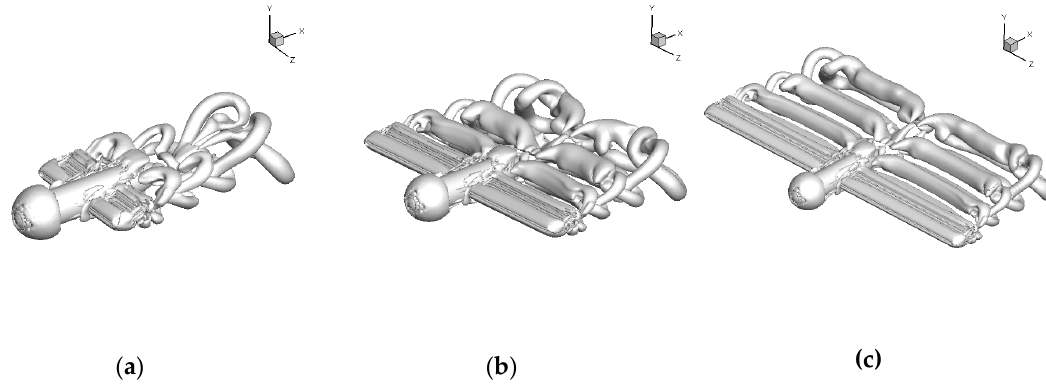
Figure 9. View of vortex structures for three typical AR values ( a ) AR = 1.0; ( b ) AR = 1.0; and ( c ) AR = 5.0.